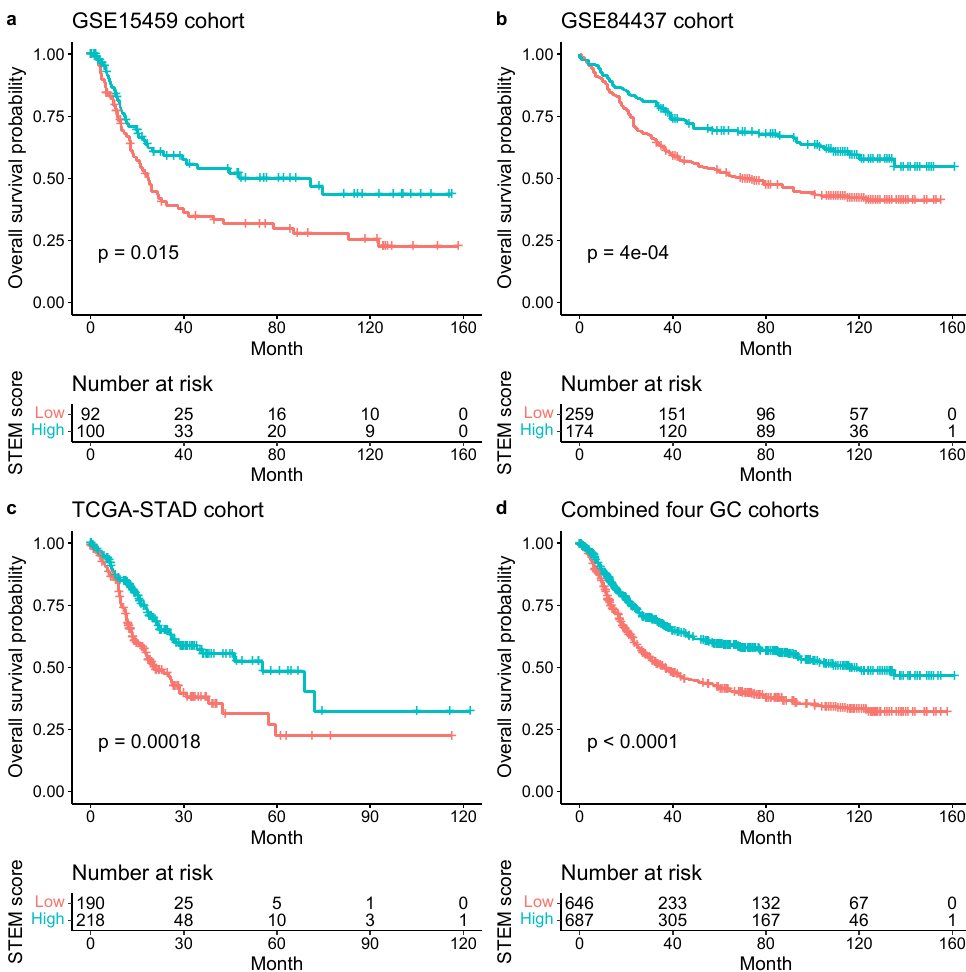
Figure 13. Kaplan–Meier plots for the OS of patients with low vs. high STEM scores in the GSE15459 ( a ), GSE84437 ( b ), TCGA-STAD ( c ) cohorts and a combined set of four cohorts (ACRG, GSE15459, GSE84437, and TCGA-STAD) ( d ). Significance test p value is shown in the lower